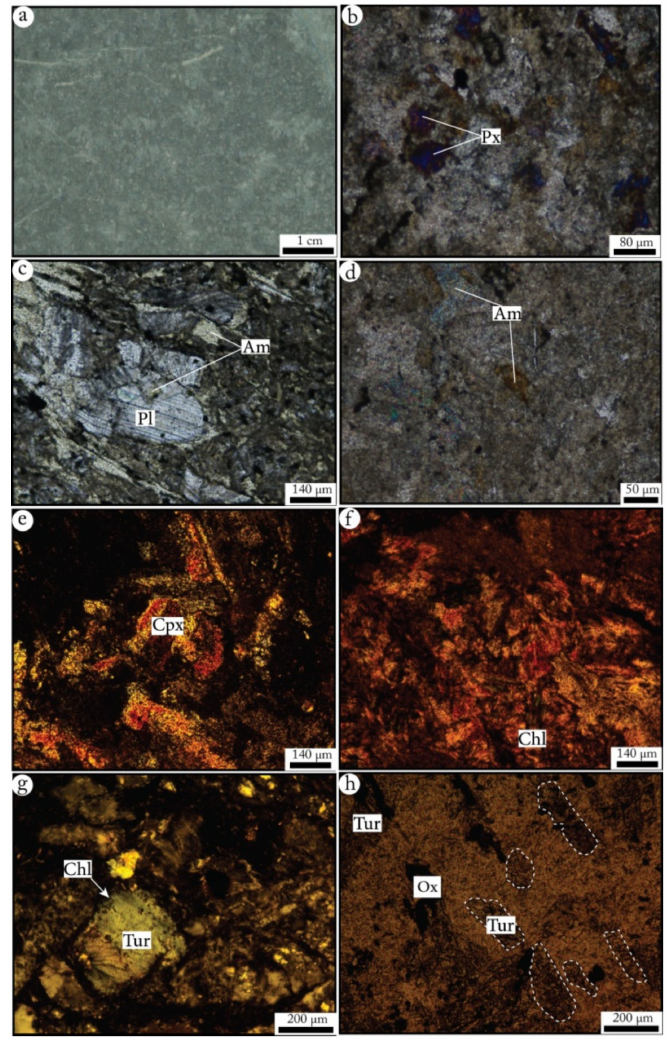
Figure 9. ( a ) Macroscopic view of a dolerite facies. ( b – h ): microphotographs of dolerites: plagioclases (Pl), amphibolitized (Am) pyroxenes (Px), clinopyroxenes (Cpx), chloritized (Chl) tourmaline (Tur) and oxides (Ox) (transmitted light—crossed